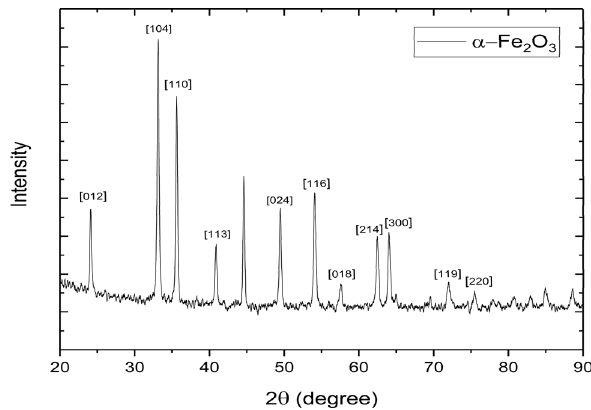
Fig. 3 X-ray diffraction pattern of synthesized hematite